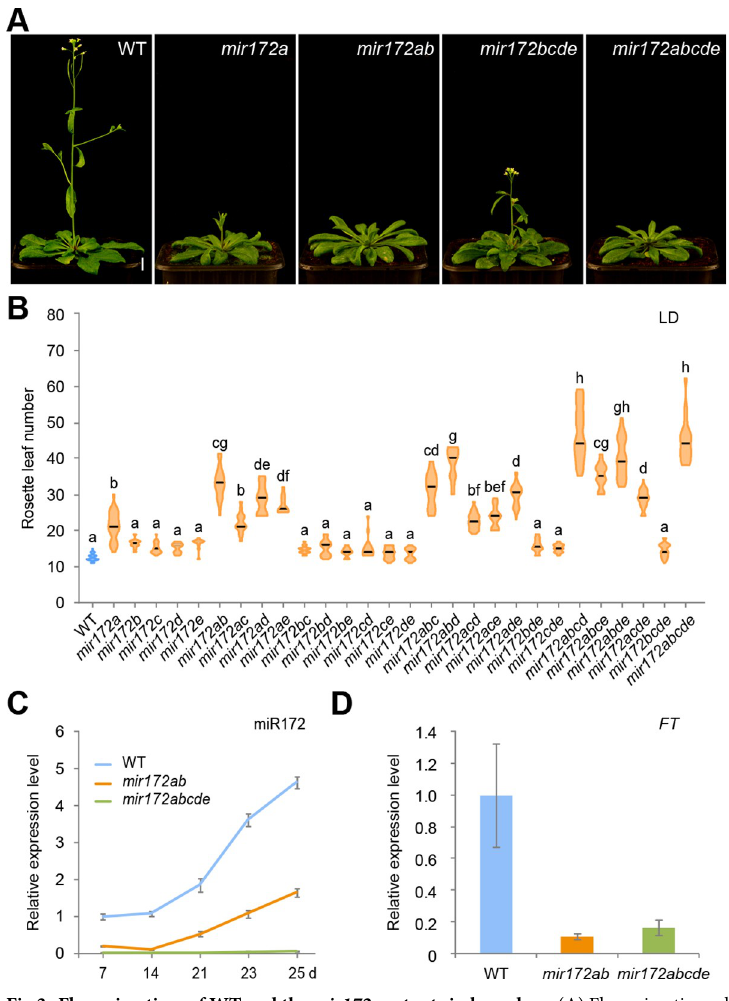
Fig 3. Flowering time of WT and the mir172 mutants in long days. (A) Flowering time phenotype of the mir172 mutants. Plants were grown at 22˚C in long days. One representative plant is shown. (B) Quantification of flowering times of the mir172 mutants. Lines show mean ( n = 7–36). The statistically significant differences are determined by ordinary one-way ANOVA ( p < 0.05). See also S1 and S4 Tables. (C) Expression of miR172 in WT, mir172ab , and mir172abcde mutants. Plants were grown at 22˚C in long days. The shoot apices and developing leaves were used for qRT-PCR analysis. Expression was normalized to TUB . Two technical replicates for each biological replicate ( n = 2) were performed. Error bars represent SD. (D) Expression of FT in WT and the mir172 mutants. The leaves of 15-day- old plants grown at 22˚C in long days were harvested at ZT16 and used for qRT-PCR analyses. Expression was normalized to TUB . Two technical replicates for each biological replicate ( n = 3) were performed. Error bars represent SD. The data underlying this figure are included in S1 Data. FT , FLOWERING LOCUS T ; LD, long days; qRT-PCR, quantitative real-time PCR; TUB , β -TUBULIN-2 ; WT, wild type; ZT16, Zeitgeber time 16.